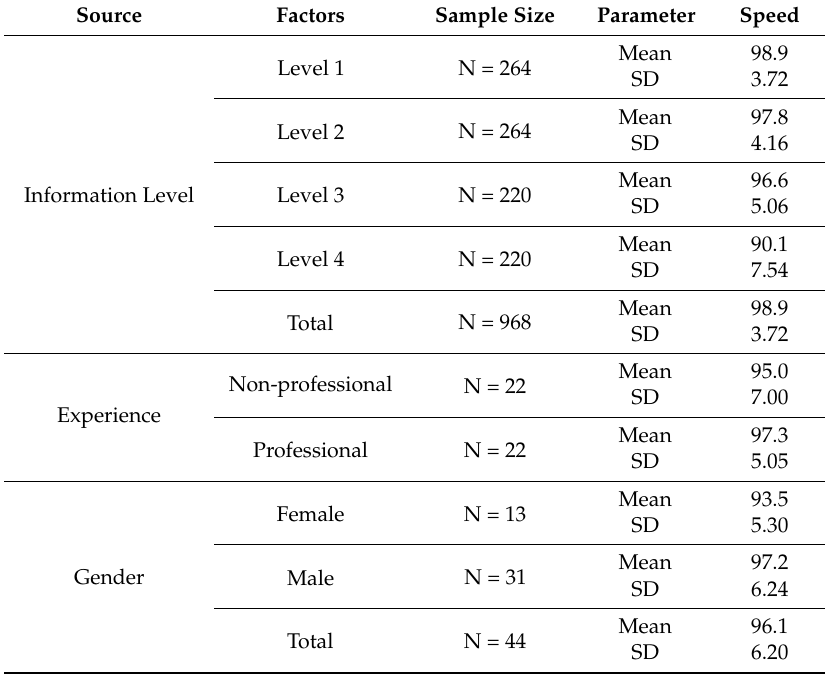
Table 6. Descriptive statistical results for driving speed under workload.